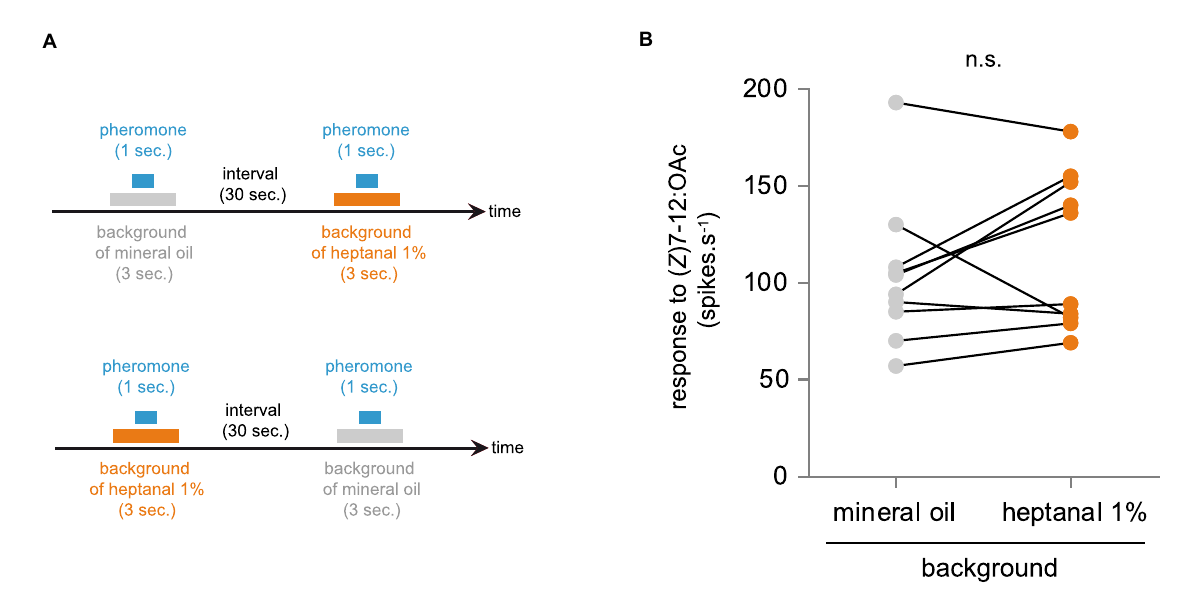
FIGURE 4 Effect of a background of heptanal on AipsOR3 function. (A) Protocol used to compare ( Z )7-12:OAc responses of at1 neurons expressing AipsOR3 with or without a heptanal background. Neurons were alternatively stimulated with the neutral background (mineral oil) first or with the heptanal background first. (B) Action potential frequency of at1 neurons expressing AipsOR3 ( n = 10) in response to ( Z )7-12:OAc (10 μ g in the glass vial) in a background of heptanal (1 mL of heptanal 1% in the glass vial). n.s., no significant difference between the two treatments (paired t -test, significance threshold set to